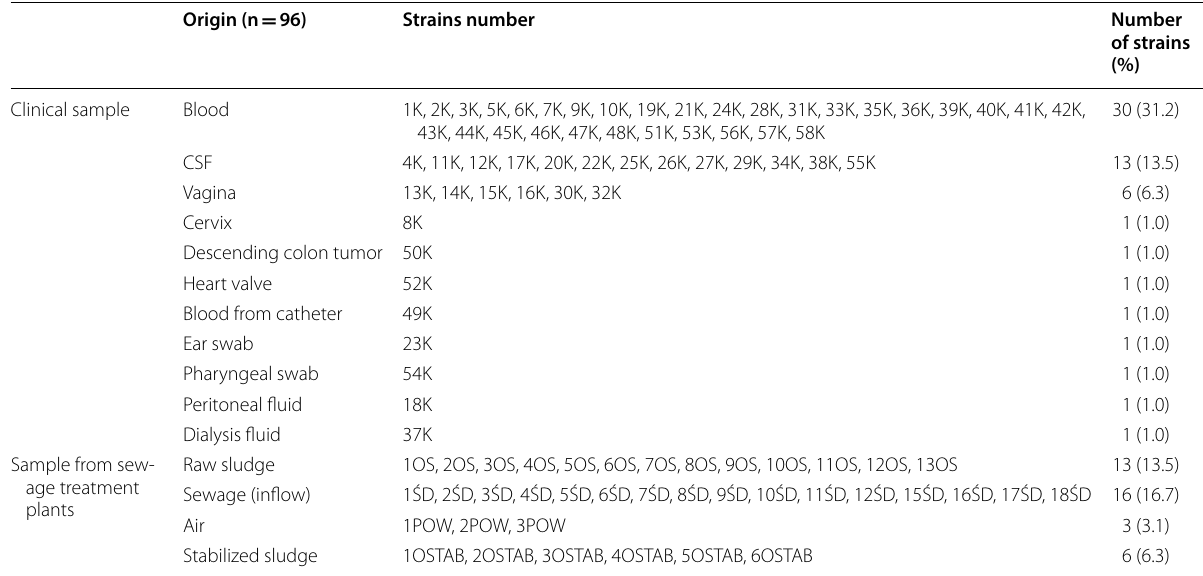
Table 1 Listeria monocytogenes strains